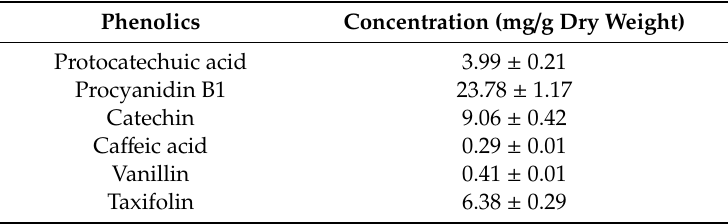
Table 1. Concentrations of phenolics in Korean red pine ( Pinus densiflora Sieb. et Zucc.) bark extract measured using reversed-phase high-performance liquid